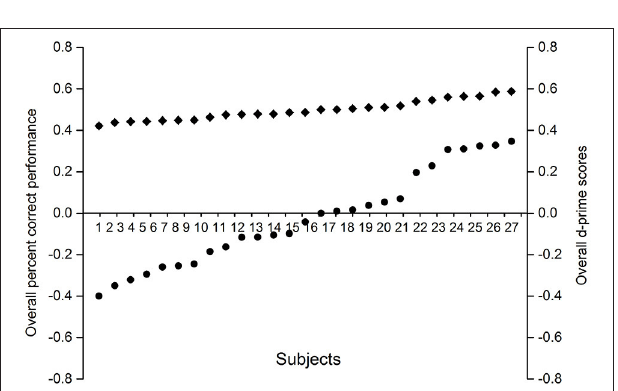
FIGURE 7 | Individual overall proportions correct and d’ scores on the prime awareness measures. Filled circles correspond to the individual d’ scores, whereas filled diamonds correspond to the individual percent correct scores. FIGURE 8 | Mean reaction time to the winning and losing body targets with congruent and incongruent primes. ** p <